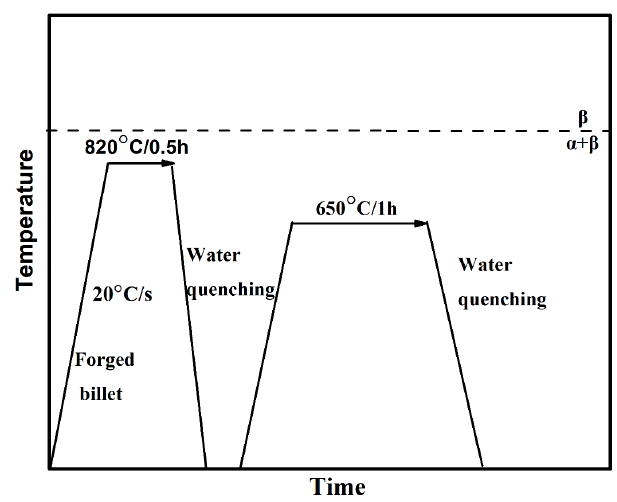
Figure 1. Schematic processing route for bi-modal microstructure.